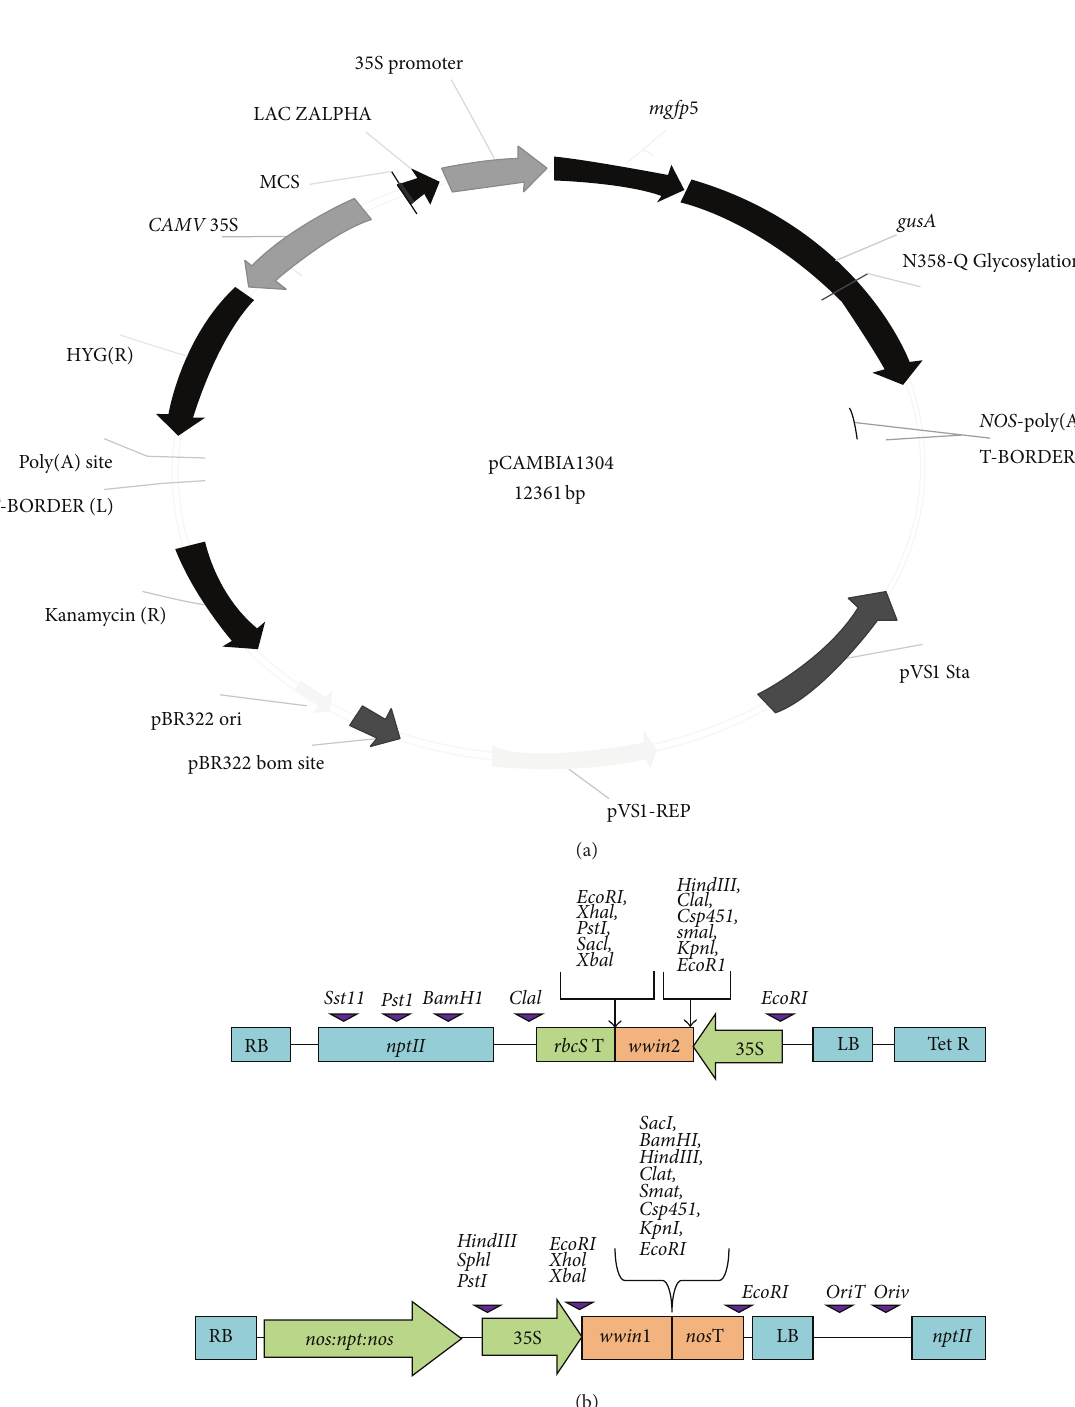
Figure 2: Schematic diagram of the plasmid used for optimization and transformation studies. (a) The binary vector pCAMBIA 1304 (CSIRO, Australia) harboring the reporter gusA and mgfp5 genes driven by the CaMV 35S promoter. (b) Recombinant plasmids pW2KY and pW1B1 containing wwin2 and wwin1 genes, respectively. RB: right border, LB: left border, nos promoter: nopaline synthase promoter, nos T: nopaline synthase terminator, nptII : neomycin phosphotransferase resistance gene, nos poly(A): nopaline synthase polyadenylation signal, wwin1 : coding region of the PR4, wwin2 : coding region of the PR4, 35S promoter: cauliflower mosaic virus (CaMV) 35S promoter, and rbcS poly(A): ribulose-1,5-bisphosphate carboxylase small subunit gene polyadenylation signal. Relevant restriction sites are also